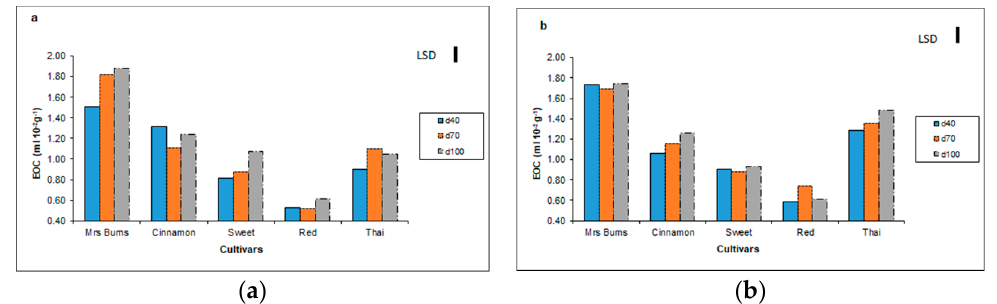
Figure 2. Essential oil content (EOC) of the five basil cultivars at the three irrigation levels (d 40 , d 70 , and d 100 ) for 2015 ( a ) and 2016 ( b ). Data presented are mean values of the three growth stages; vertical bar corresponds to the least significant difference (LSD).